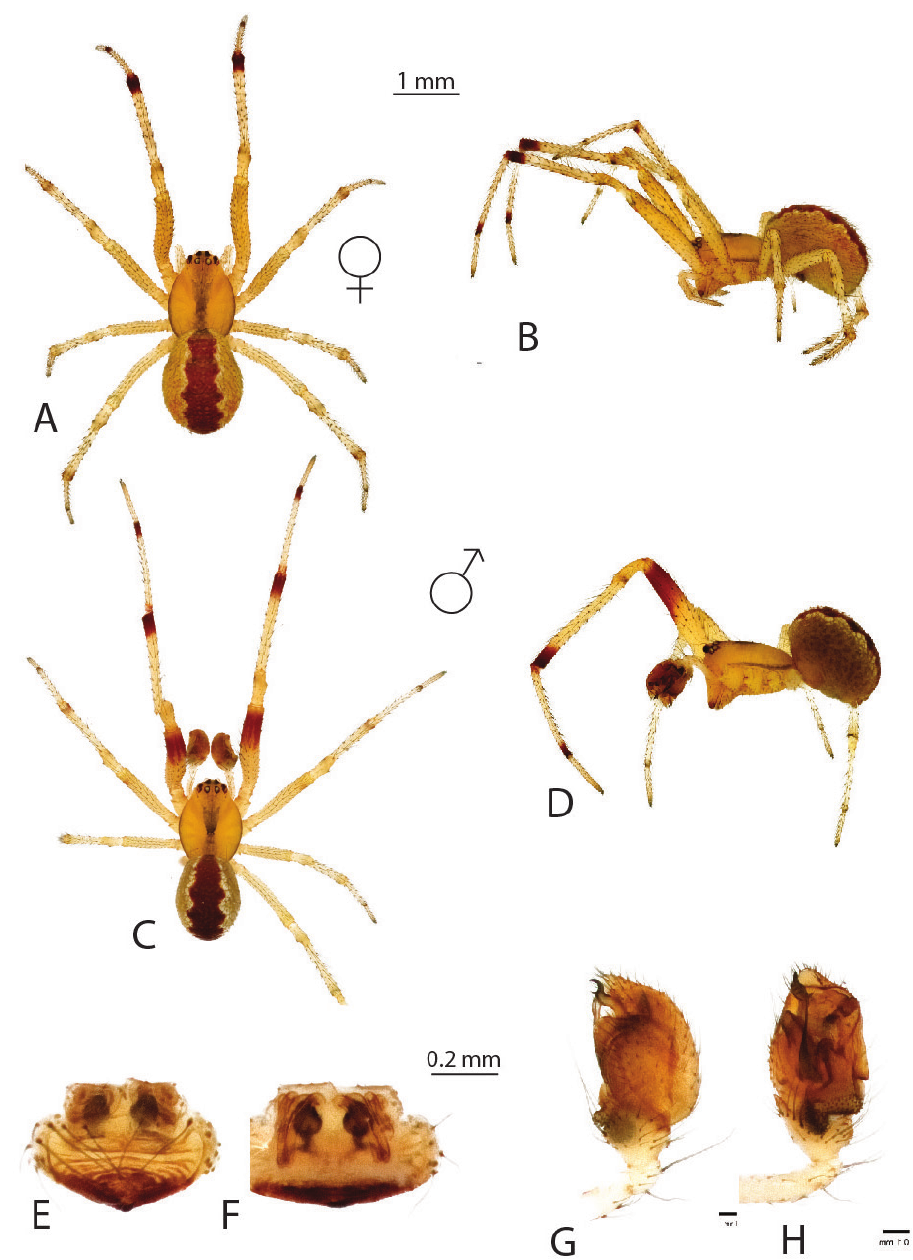
Figure 17. Anelosimus decaryi : A–B female dorsal, lateral C–D male dorsal, lateral E–F epigynum ventral, dorsal G–H male palp mesal,